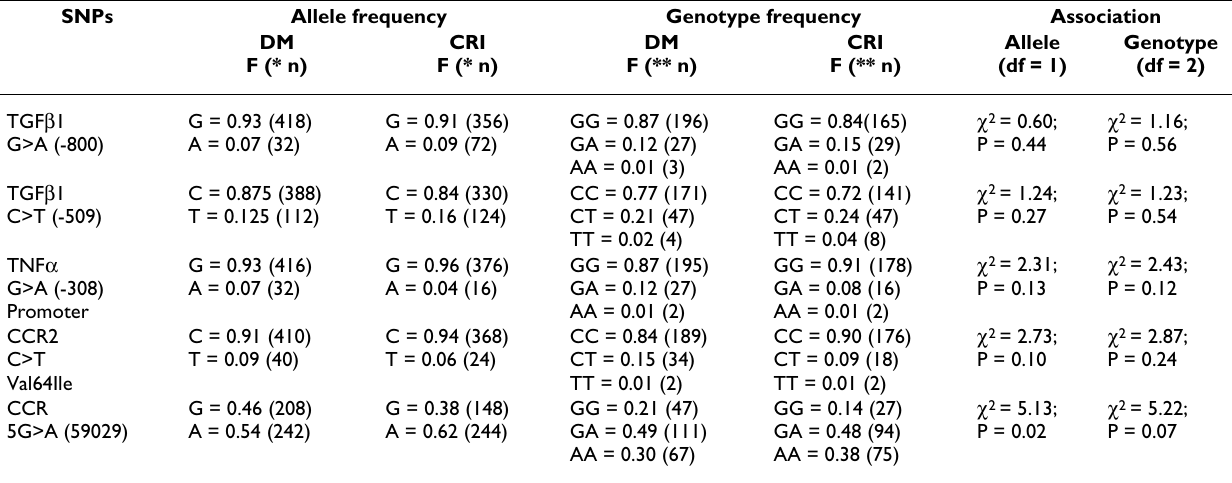
Table 2: Allele and genotype frequencies (F) of SNPs and their association status with chronic renal insufficiency SNPs Allele frequency Genotype frequency Association